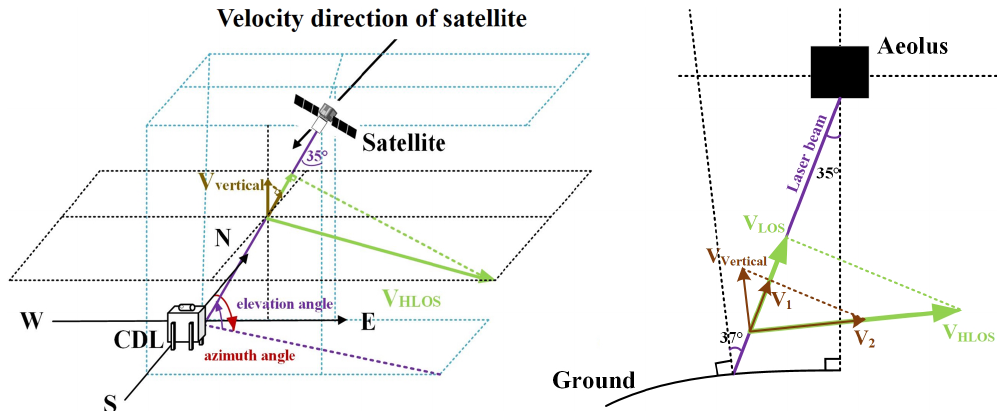
Figure 5. The schematic diagram of the vertical velocity impact on the HLOS wind velocity retrieval of Aeolus.